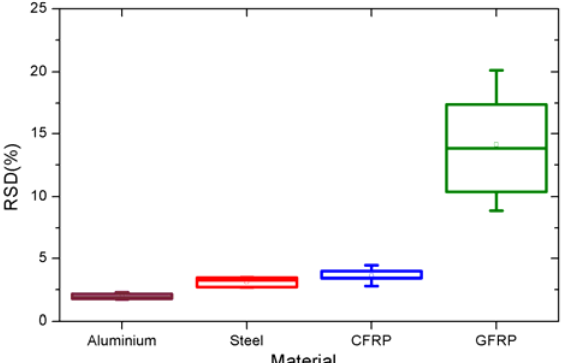
Figure 7. The variation of the estimated thermal diffusivity of a sample based on five tests of each material (three tests for the same sample and two tests for two other different samples).